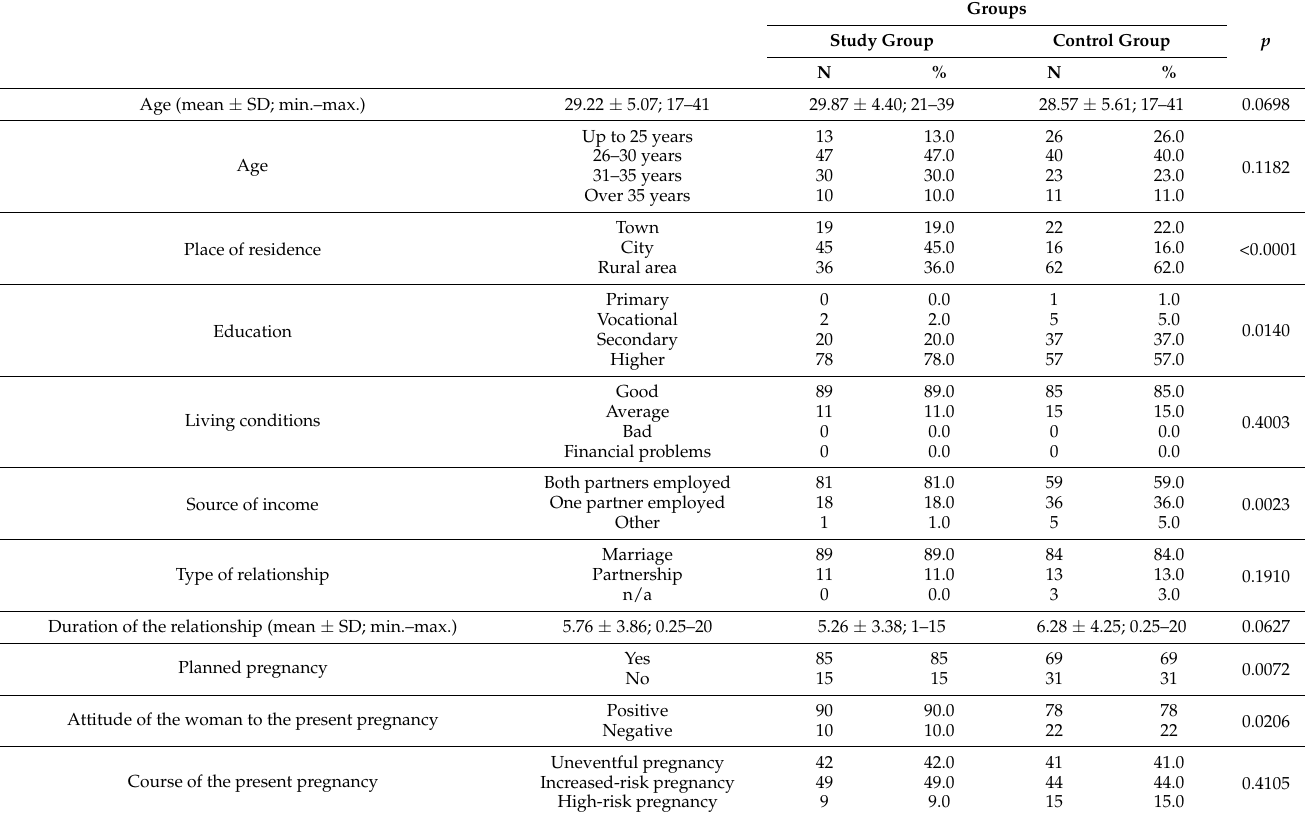
Table 1. Characteristics of the respondents with a breakdown into the group participating in antenatal classes (study group) and the group not participating in antenatal classes (control group).